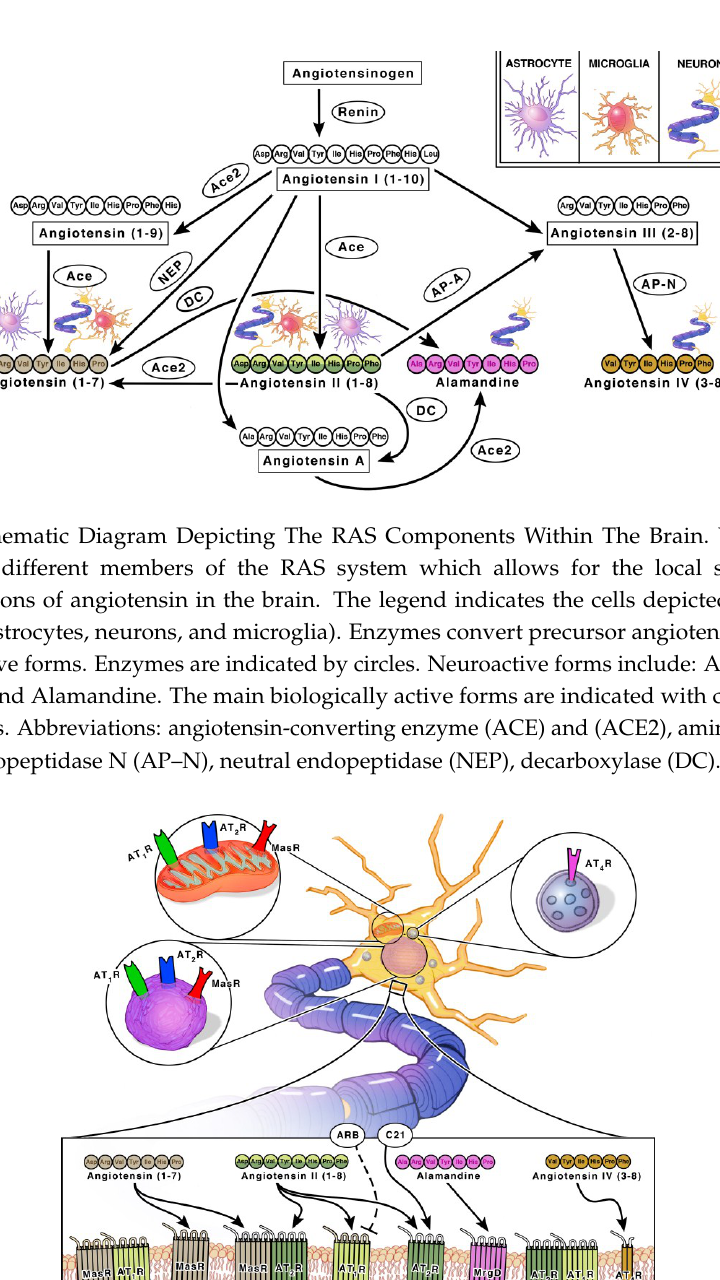
Figure 2. Schematic Diagram Depicting Neuronal Plasma Membrane and Intracellular RAS Signaling. Angiotensins II, IV, (1–7), and Alamandine are the main neuroactive forms and their signaling is indicated by arrows leading to their receptors. Receptors can form heterodimers. In the case of the MasR/AT2R heterodimer, arrows leading to the receptor from its ligands indicate its functionality. The AT2R/AT1R and MasR/AT1R heterodimers are inactive, indicated by an absence of arrows. Angiotensin (1–7) binds MasRs with the highest affinity, but can also bind AT2Rs and MrgDs. Angiotensin II binds AT1Rs and AT2Rs with the highest affinity. Alamandine binds MrgDs with the highest affinity. Angiotensin IV binds AT4Rs with the highest affinity, but can also bind AT1Rs. Angiotensin III is not depicted here since it is not a main neuroactive peptide, it binds AT2Rs with the highest affinity, but can also bind AT1Rs. Receptors can be located on the plasma membrane or intracellularly. Intracellular locations include the nucleus, mitochondria and neurosecretory vesicles. Therapeutics such as Angiotensin II type I receptor blockers (ARBs) and the AT2R agonist, Compound 21 (C 21 ) can be used to modulate receptor